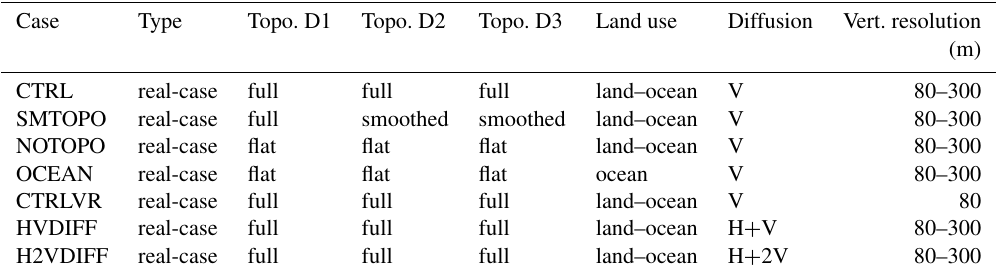
Table 2. Overview of real-case simulations for cases with full (CTRL), smoothed (SMTOPO) and without (NOTOPO) topography and for cases with a flat water surface (OCEAN) and increased vertical grid resolution (CTRLVR). Horizontal turbulent diffusion (H) is switched on in the HVDIFF case, and vertical diffusion (V) is doubled in the H2VDIFF